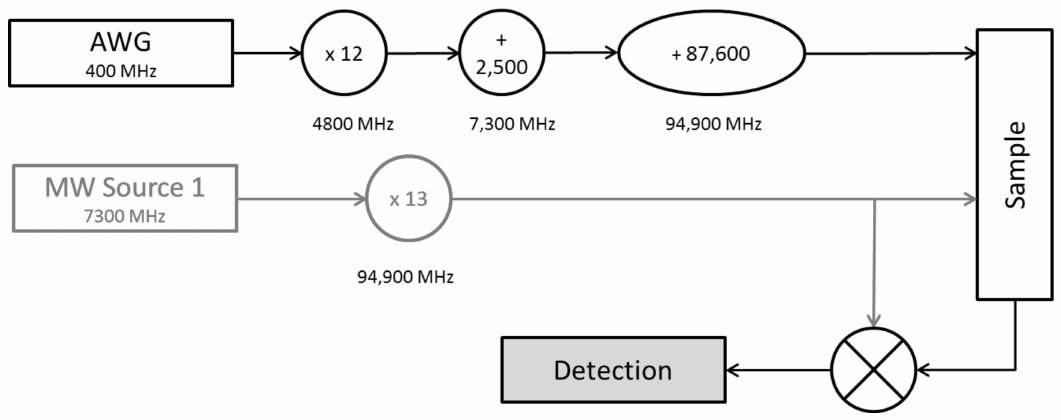
Figure 6. The scheme of the arbitrary waveform generator (AWG)